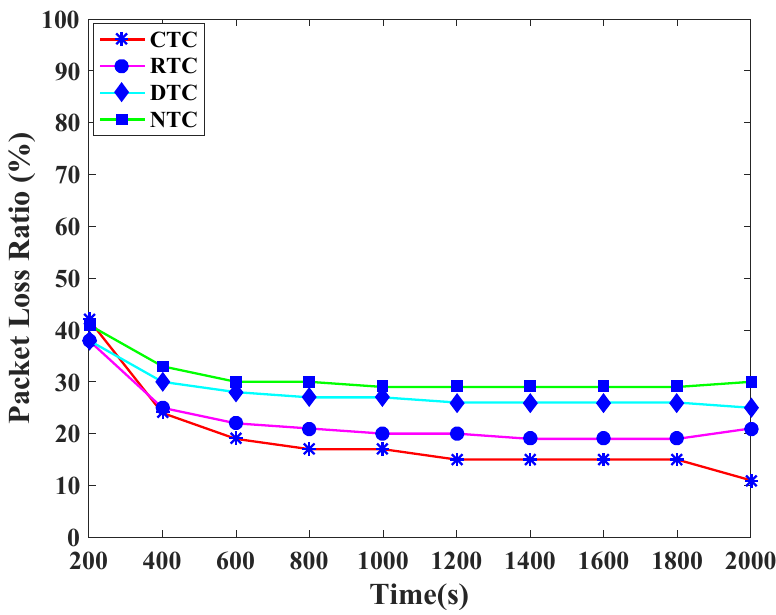
Figure 10. Packet loss ratio versus time in seconds.